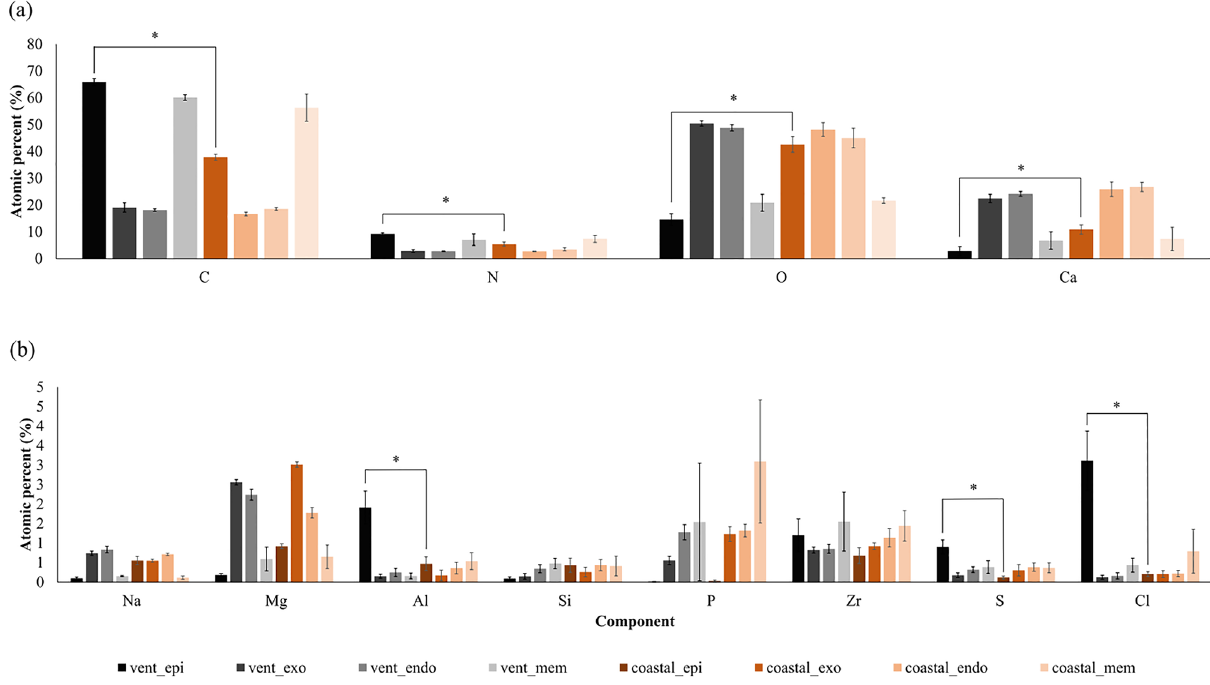
Figure 4. Component analysis results using EDX. Comparison of ( a ) main and ( b ) minor elements of the exoskeleton between the two crabs [significant difference is indicated by an asterisk (*)] (mean ±